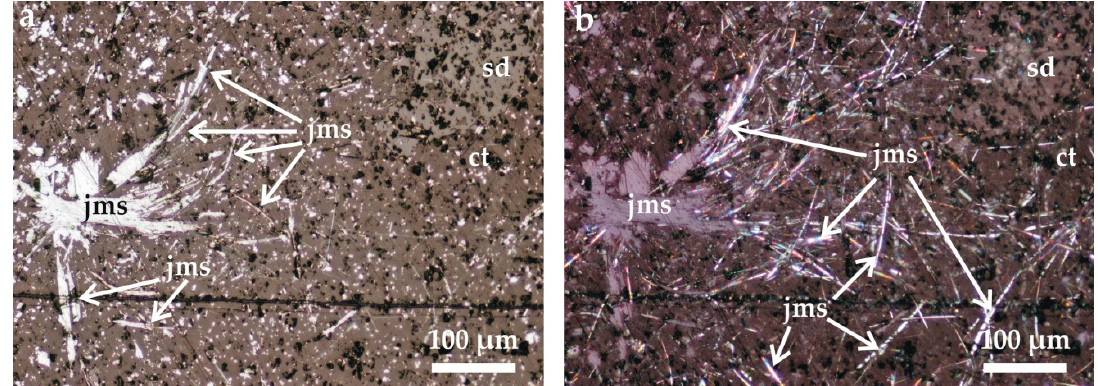
Figure 13. Reflected light microphotographs in plane polarized light ( a ) and in crossed polarizers ( b ) of black calcite from Herja. The real size of needle-like jamesonite crystals hosted by calcite and not entirely exposed at the surface of the polished section is better seen in (b) due to transparency of calcite and reflection of light upon jamesonite crystals “sunk” within calcite. Abbreviations: jms, jamesonite; ct, calcite; sd, siderite.